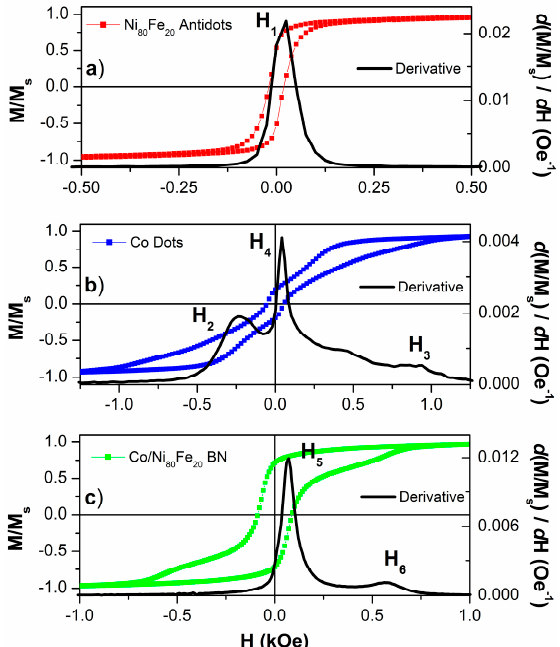
Figure 3. (Colour online) Room temperature, in-plane hysteresis loops of Ni 80 Fe 20 antidot arrays ( a ), Co dot arrays ( b ) and bi-component nanostructured systems ( c ). Black lines are the field derivative of the lower branch of the M/M S experimental values. Horizontal scales have been adjusted to put in evidence the features of the loops for the different samples.